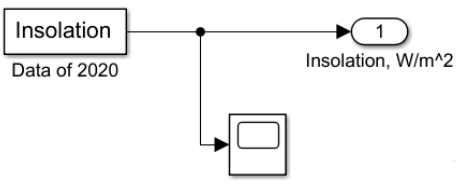
Figure 5. Solar Energy Matlab/Simulink model subsystem.